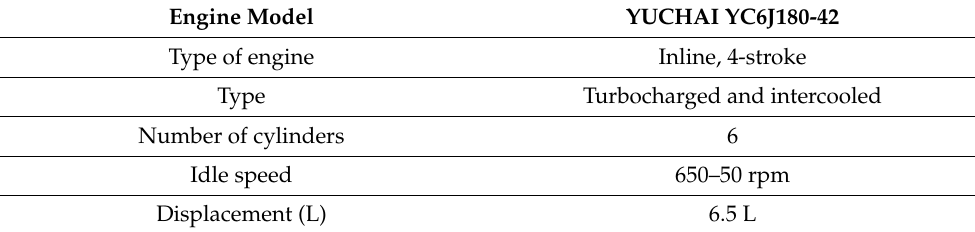
Table 5. Specification of engine and aftertreatment system, adapted from Wei et al. [45,67].